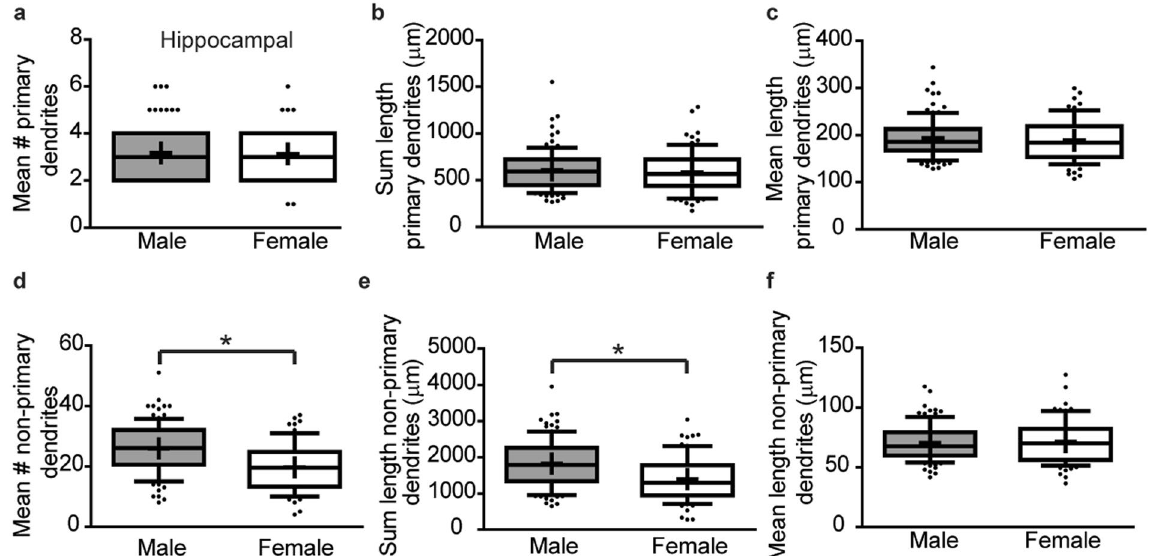
Figure 3. In vitro sex differences in the dendritic morphology hippocampal neurons are primarily due to differences in the number of non-primary dendrites. Male vs. female neuron-glia co-cultures were established from P0 hippocampi, transfected with MAP2B-GFP plasmid on day in vitro (DIV) 6 and fixed on DIV 9. Dendritic morphology was assessed by quantifying: ( a ) the number of primary dendrites; ( b ) the summed length of primary dendrites; ( c ) the mean length of primary dendrites; ( d ) the number of non-primary dendrites; ( e ) the summed length of non-primary dendrites; and ( f ) the mean length of non-primary dendrites. In the box plots, “ + ” indicates the mean; whiskers, the 10–90 th percentile (n = 76–101 neurons per sex from at least five independent dissections). Significant differences were determined using Student’s T-test for parametric data ( e ) and Mann-Whitney U test for nonparametric data ( a , b , c , d , f ). Asterisk indicates a significant difference between groups at p ≤